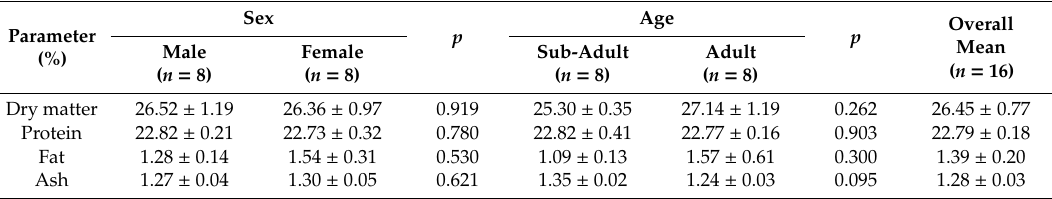
Table 1. Proximate chemical composition of axis deer longissimus thoracis , as influenced by sex and age (mean ±